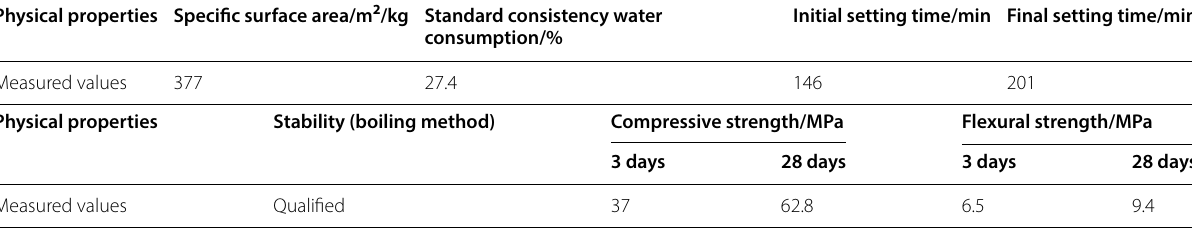
Table 4 Physical and mechanical properties.